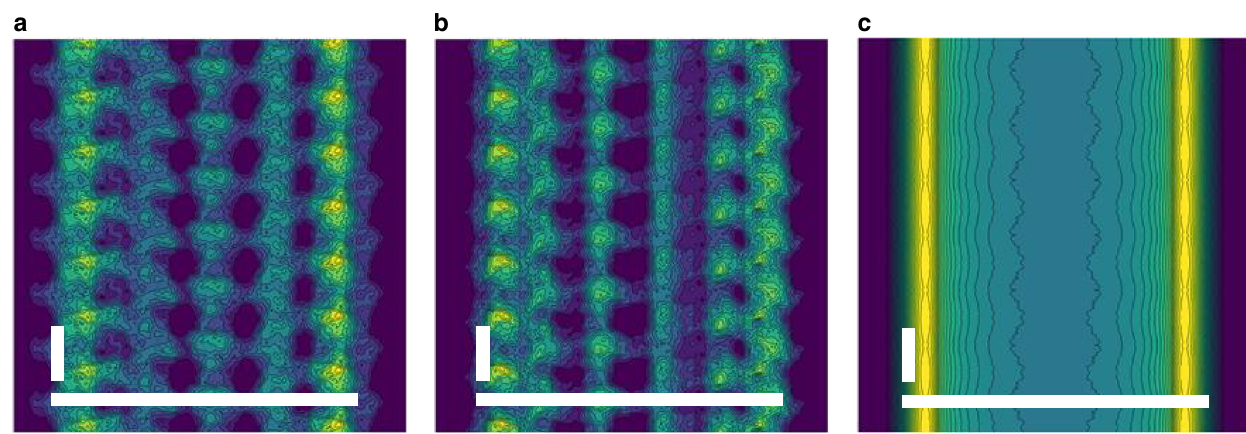
Fig. 6 Oversimpli fi ed model illustrating single fi bril snapshots. a Iterative phase retrieval image recovered from theoretical data generated from projection images of a single snapshot of a simpli fi ed helical model constructed from 4 nm spheres. b Iterative phase retrieval image recovered from the same object but rotated by 66° relative to its orientation in ( a ). c Iterative phase retrieval image recovered from the same object but averaged over 360° of rotation about its helical axis. White bars indicate 25 nm in the horizontal direction and 4 nm in the